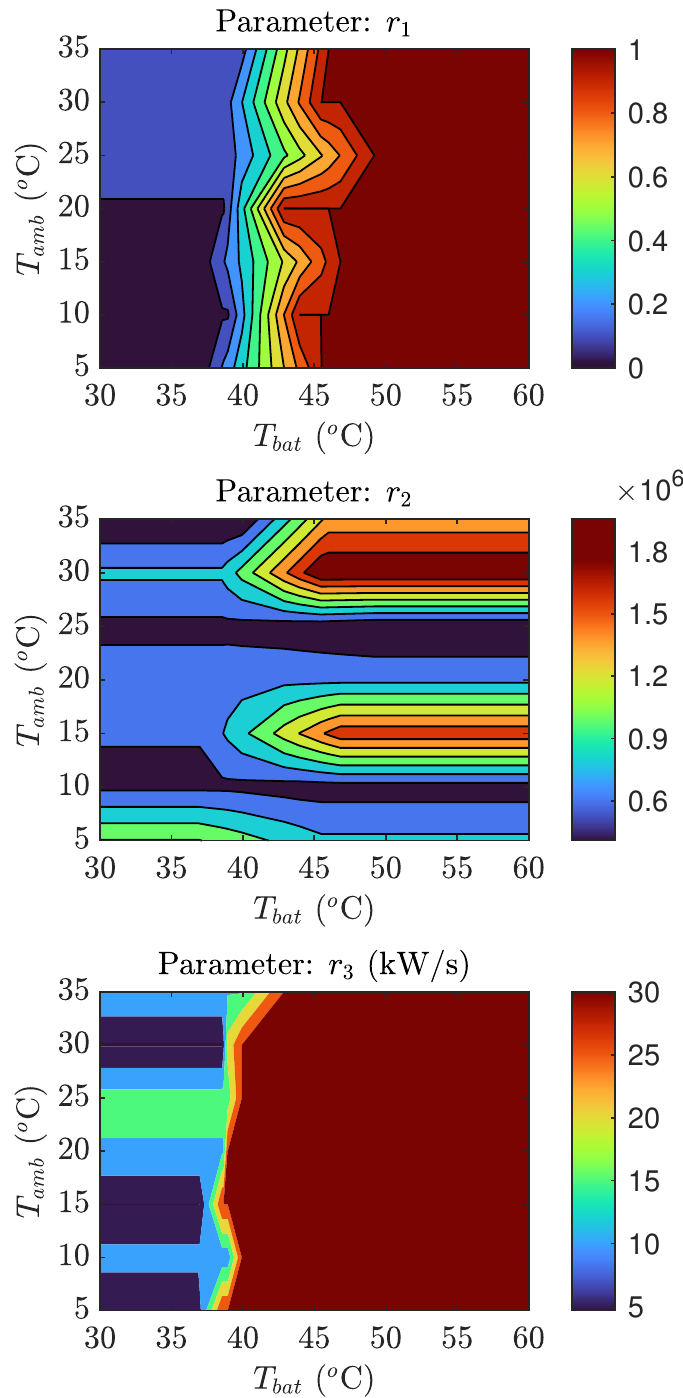
Figure 10. Adaptive EMS parameters resulting from the optimal calibration process. Each parameter is mapped against ambient and battery